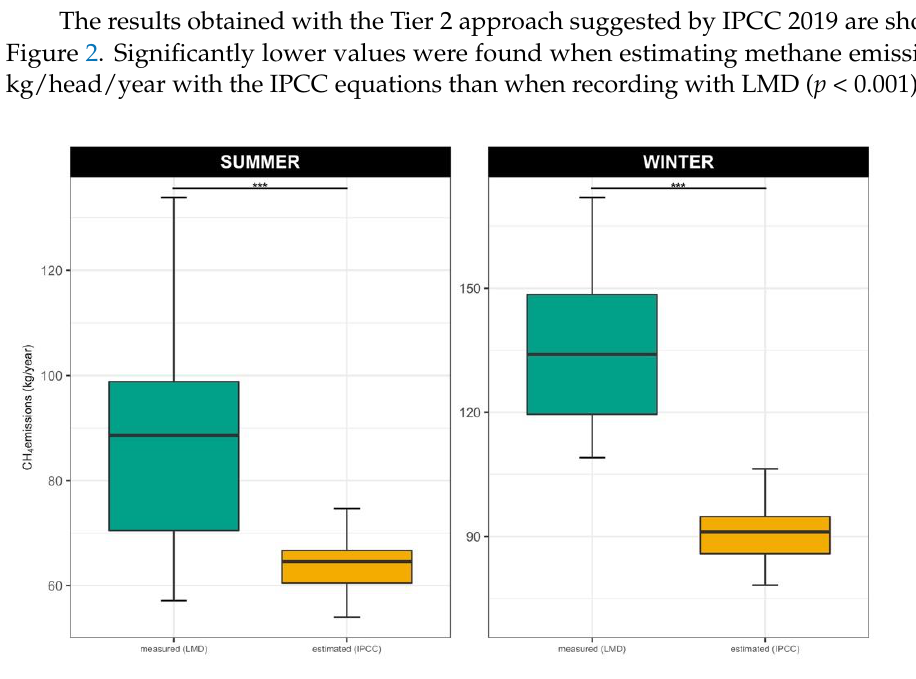
Figure 2. Seasonal CH 4 average values (kg/head/year) estimated with IPCC equation or measured with LMD (*** = p < 0.01 between estimated and measured values).